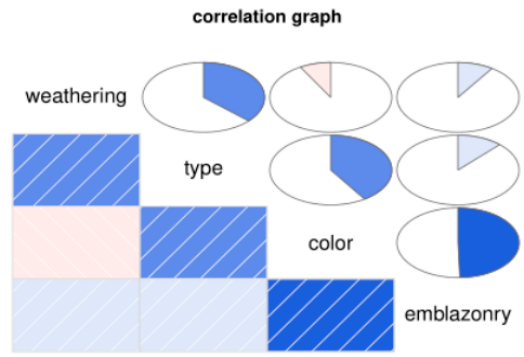
Figure 2. Correlation diagram among columns.